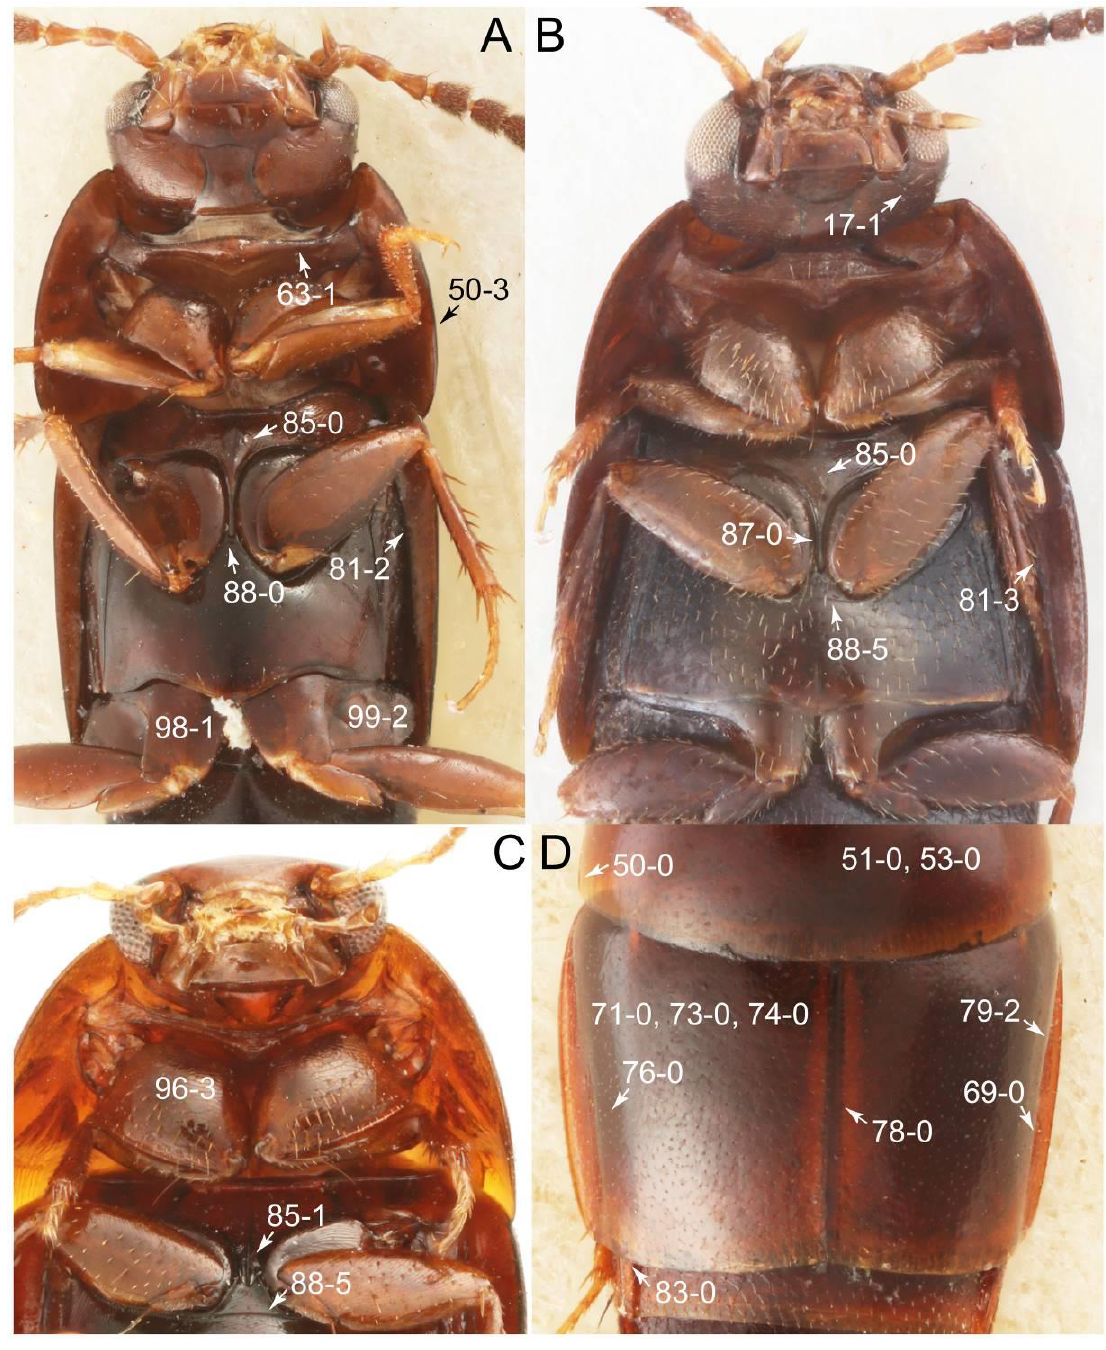
Figure 24. Photographs of body parts of Vatesini, enlarged. ( A ) forebody of Cileoporus fenestratus , ventral view. ( B ) forebody of Coprotachinus habrocerinus , ventral view. ( C ) pronotum and intermesocoxal processes of Coproporus laevis , ventral view. ( D ) elytra of Coproporus colchicus , dorsal view. Characters and character states (format X-X) are indicated on each